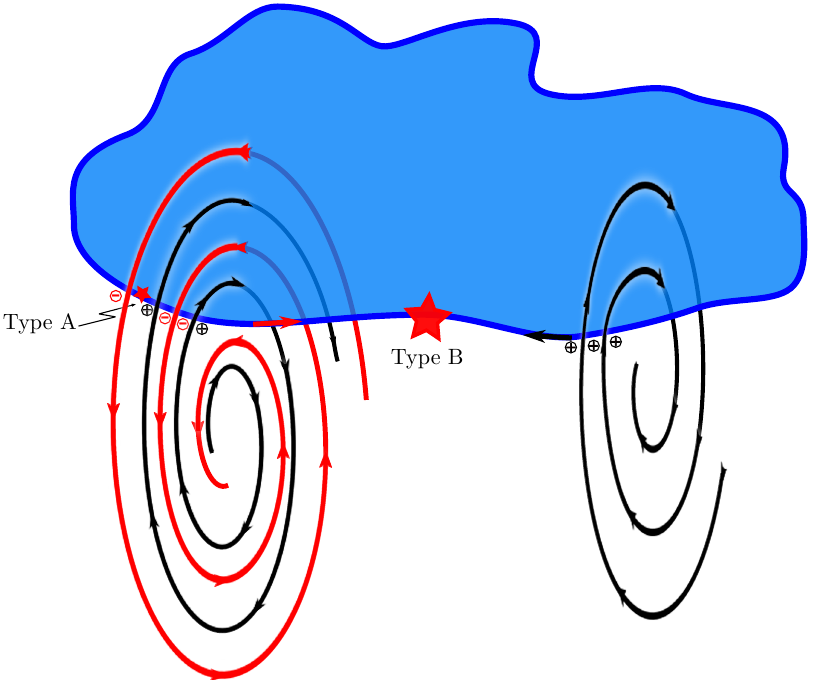
Figure 2 . A schematic presentation of the two types of plasma collisions that can occur in the universe, as the string is moving through the universe. Type A collisions (small red star) happen when the axion string (blue solid line) moves through magnetic field regions with different orienta- tion in the dipolar galactic magnetic field [40]. This leads to a collisions inside the galaxy. Type B collisions (big red star) happen when the axiverse string moves through different magnetic field regions of different galaxies inside a galaxy cluster, or different magnetic field patches inside the galaxy cluster, which leads to collisions outside of a galaxy. Both the collision and the charging and discharging of the string provides us with observable